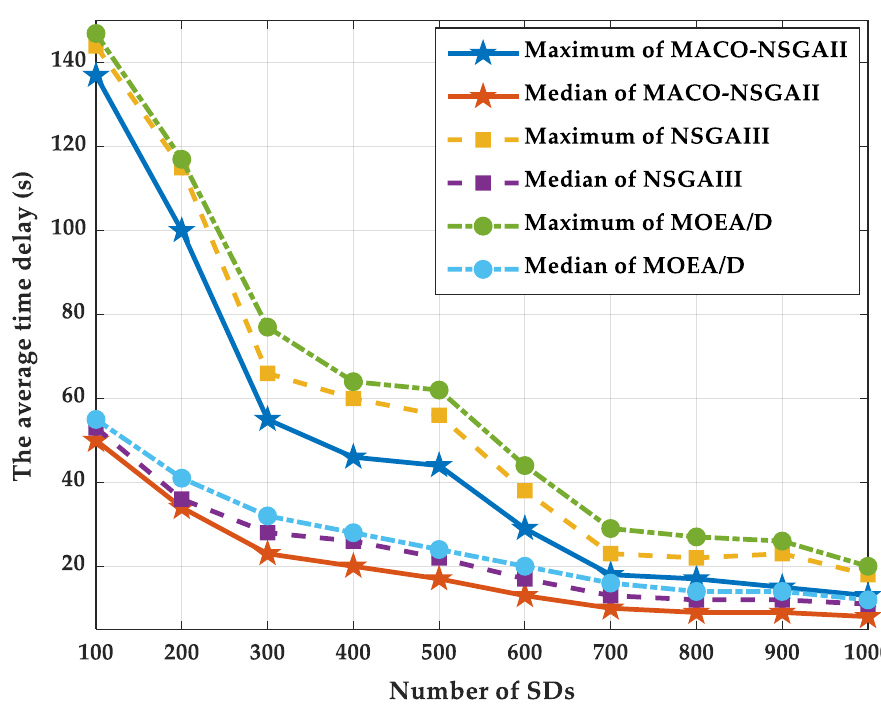
Figure 7. The average time delay of 6 UAVs with different algorithm.